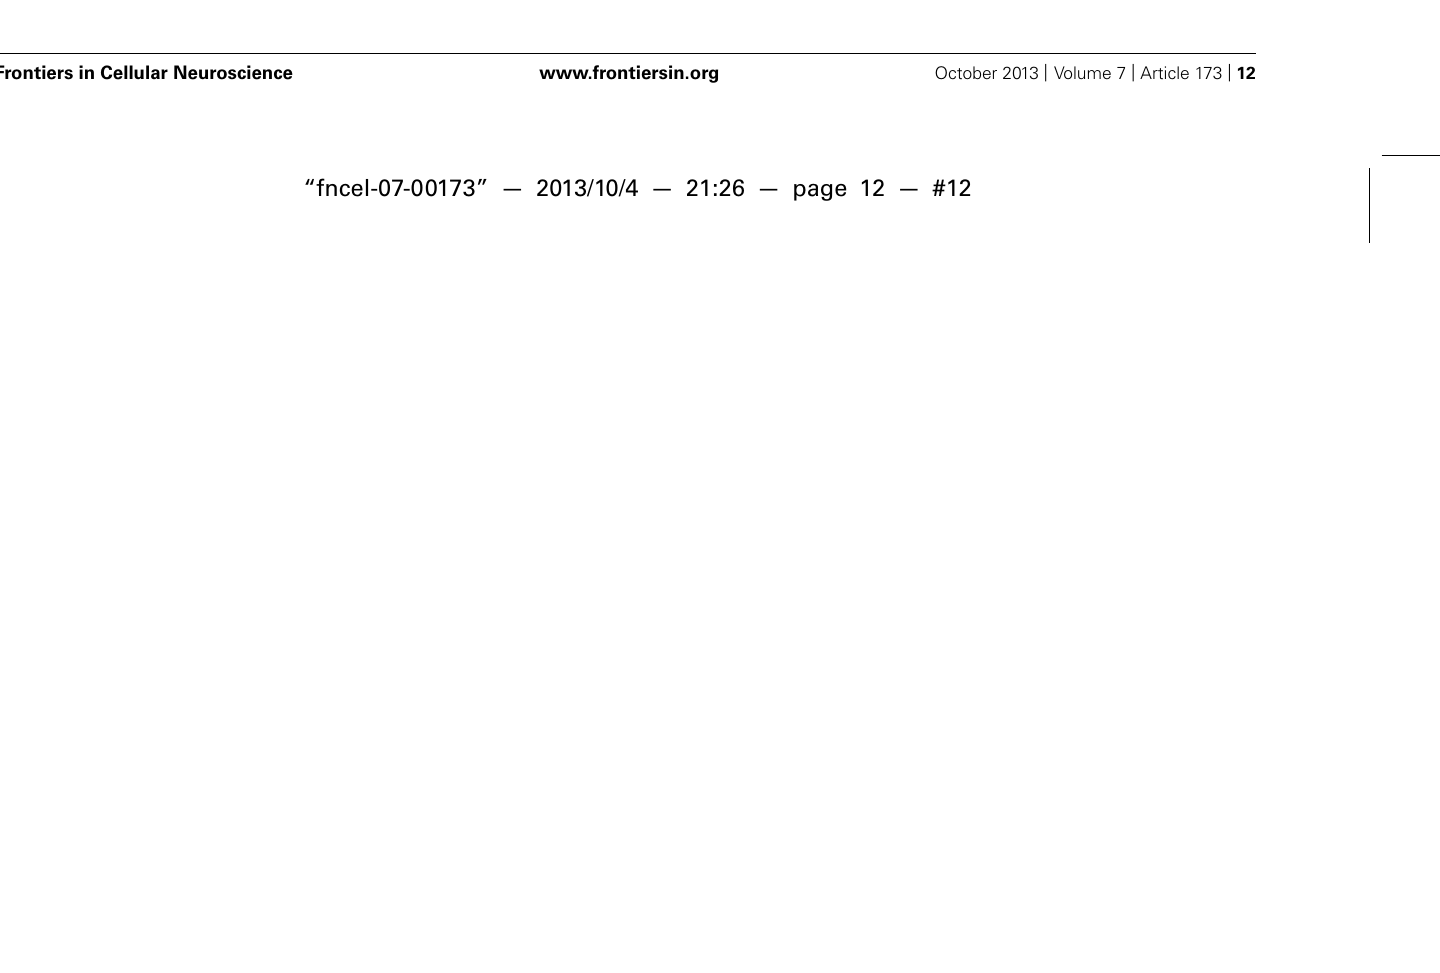
with staphylococcal enterotoxin B (SEB; A ). In line with its feed-forward effects on the HPA axis response to psychogenic stress, OFQ/N exerts stimulatory effects on the HPA axis response to systemic immune stress. Specifically, nociceptin signaling prolongs elevations in circulating CORT induced by systemic administration of SEA or LPS (B) . In the central nervous system (CNS), OFQ/N modulates the release inflammatory cytokines. Notably, nociceptin signaling appears to regulate, in a cell-specific manner, the expression of IL-1 β . In response to traumatic injury or LPS, OFQ/N attenuates the release of IL-1 β from microglial cells and astrocytes. Conversely, nociceptin signaling enhances the release of IL-1 β from neurons (C) . Abbreviations used: corticotropin releasing hormone; CRH, adrenocorticotropin hormone; ACTH, paraventricular nucleus; PVN, bed nucleus of stria terminalis; BNST, central amygdala; CeA, medial amygdala; MeA, basolateral amygdala; BLA, basolateral